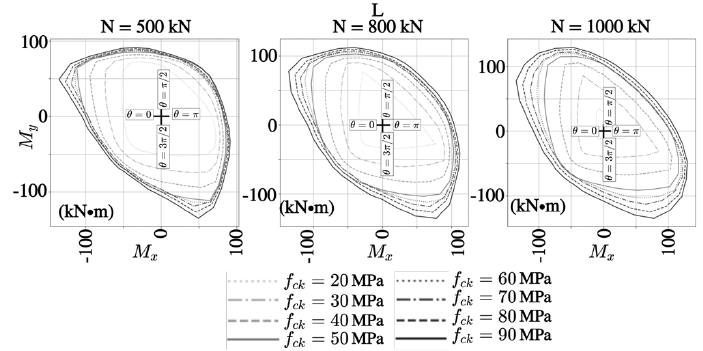
on “L” sections flexural ck f